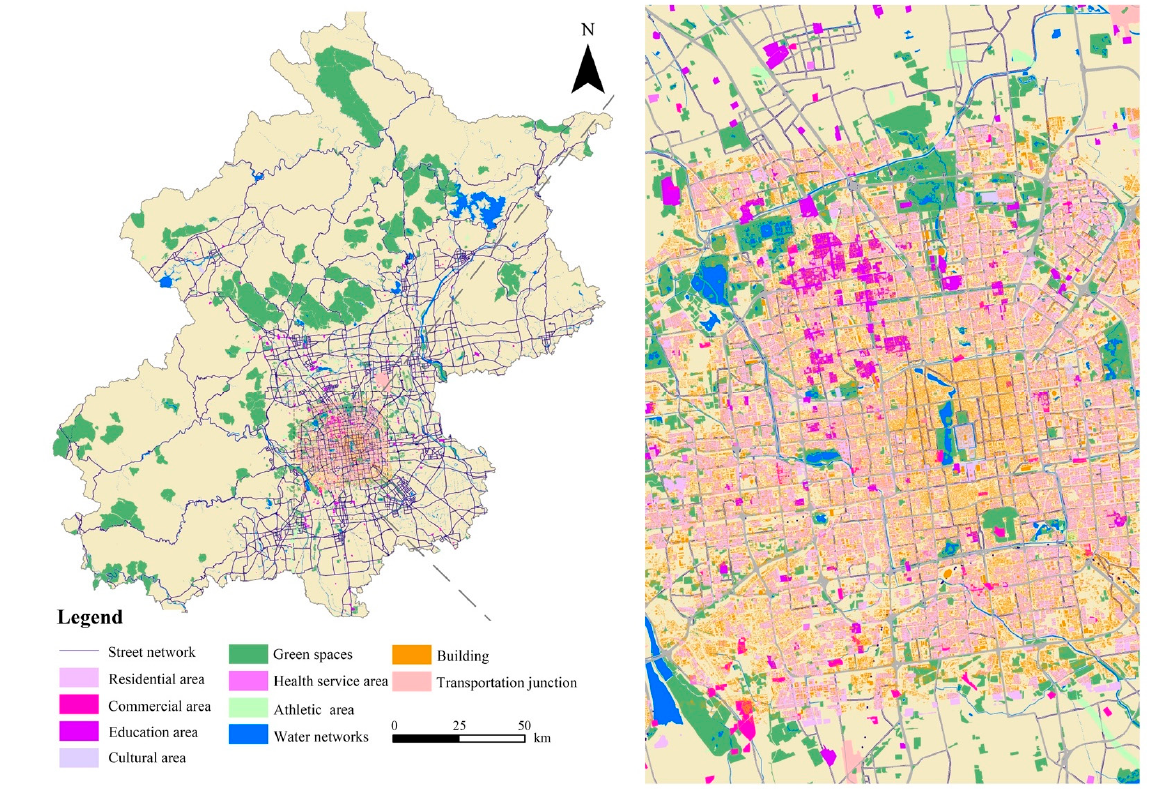
Remote Sens. 2021 , 13 , x FOR PEER REVIEW Figure 2. Land-use types ( left ) and an enlarged view inside the 5th ring-road of Beijing ( right ).